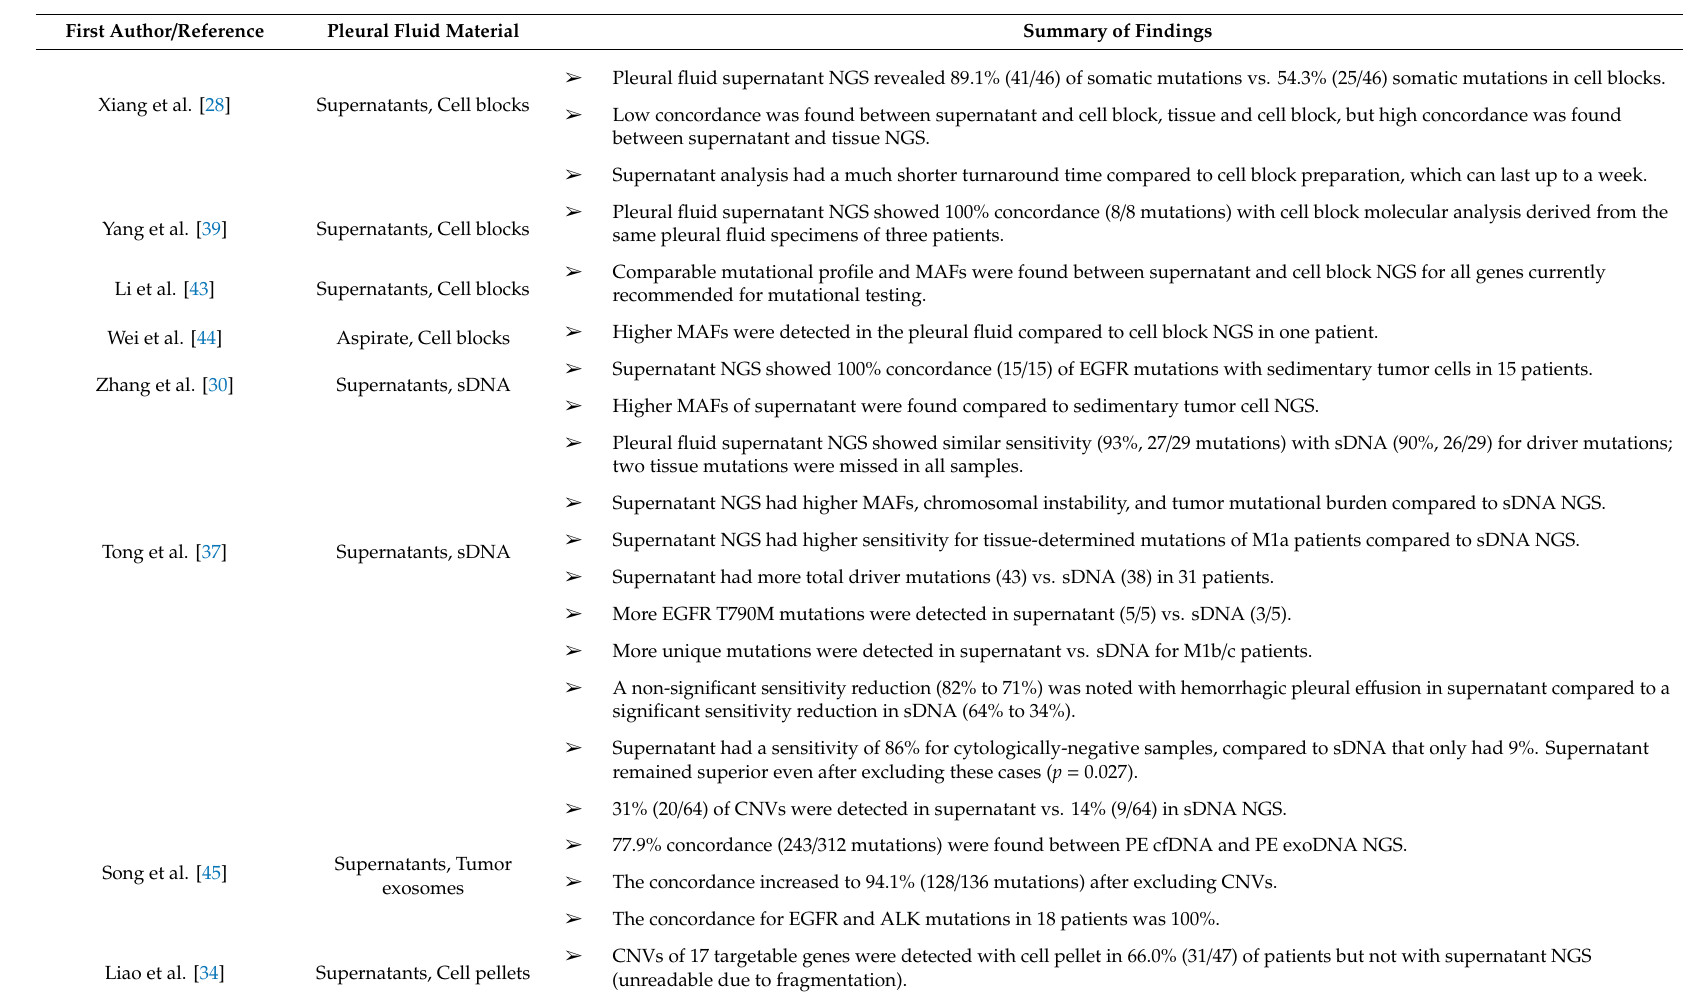
Table 3. The value of supernatant-derived